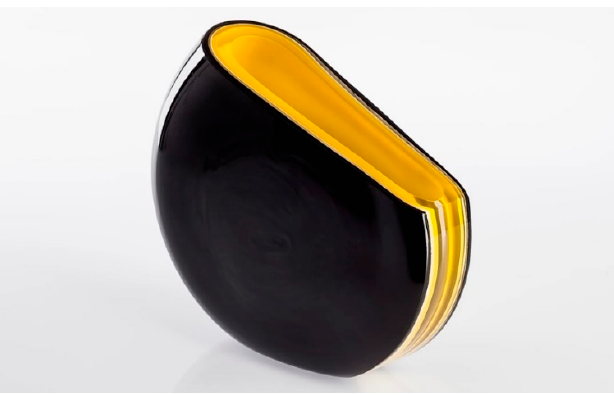
Figure 10. # Cor , Joana Silva, (glassblower: Cláudio Duarte) 2017. Photo credit: the designer.